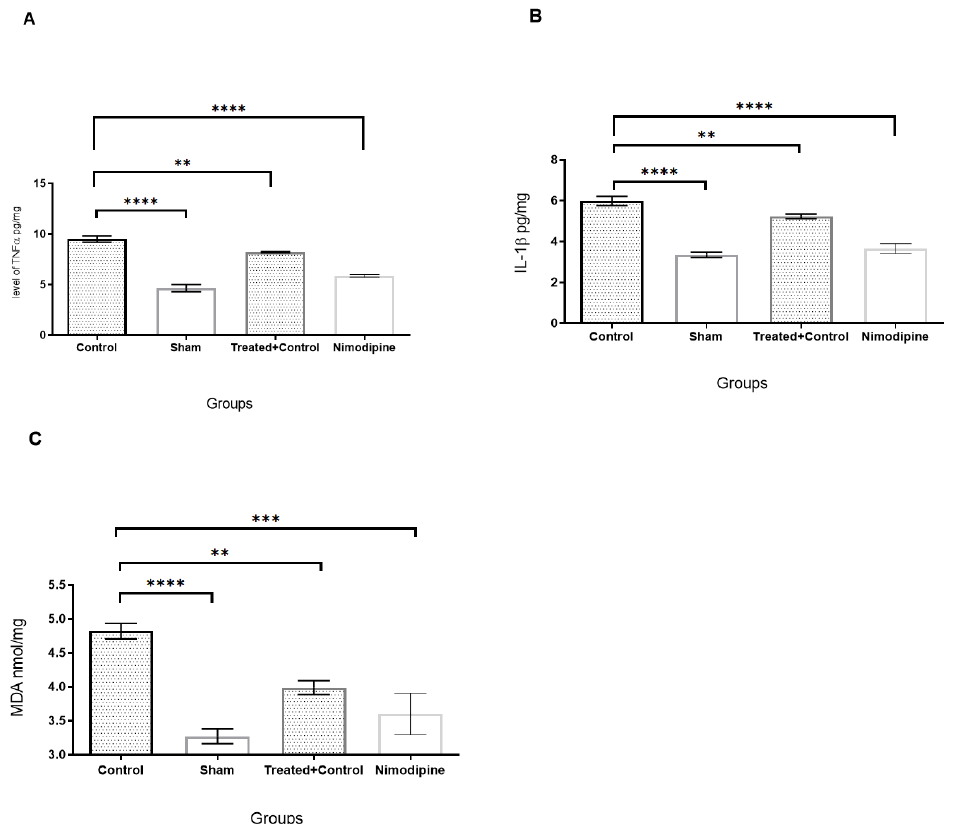
Figure 2. IFD pre-treatment reduced inflammatory cytokines and oxidative stress 24 h after ischemic stroke. ( A ): TNF- α , ( B ): IL-1 β and ( C ): MDA levels of the brain tissues of the sham, control, IFD treatment + ischemic stroke, and Nimodipine as a positive control. All values are shown as mean ± SEM. ** p < 0.01, *** p < 0.001, **** p < 0.0001. 2.3. The Anti-Inflammatory Effects of IFD May Be Mediated through pNF- κ B Protein Downreg- ulation The results of the Western blot analysis showed that BCA occlusion increased the phosphorylation of NF- κ B p65 (active form) in the control group when compared with the sham group ( p < 0.001). Of note, pre-treatment with IFD reduced its phosphorylated form significantly in respect to the control group ( p < 0.01) (Figure 3A,B). Figure 3. ( A ). Western blot of NF- κ B phosphorylation in brain tissues of groups. ( B ). IFD pre-treat- ment reduced phosphorylation of NF- κ B in animals 24 h after reperfusion. Data are shown as mean ± SEM. ** p < 0.01, *** p < 0.001. 3. Discussion IFD has attracted the attention of many researchers and academics in recent years due to its anticancer, analgesic, neuritogenic, anti-inflammatory, hepatoprotective, anti- protozoal, and insecticidal properties [5,7,8,19–22]. In the present study, we highlighted for the first time the neuroprotective effects of IFD on an acutely pre-treated ischemic stroke rat model by measuring biochemical mark- ers, pathology of the hippocampi cells, and behavioral assays. Li et al. have indicated that IFD has anti-inflammatory effects on liver injury induced by d-galactosamine/lipopoly- saccharide in rats, by reducing inflammatory cytokines such as IL6, IL-1 β , and TNF- α ,